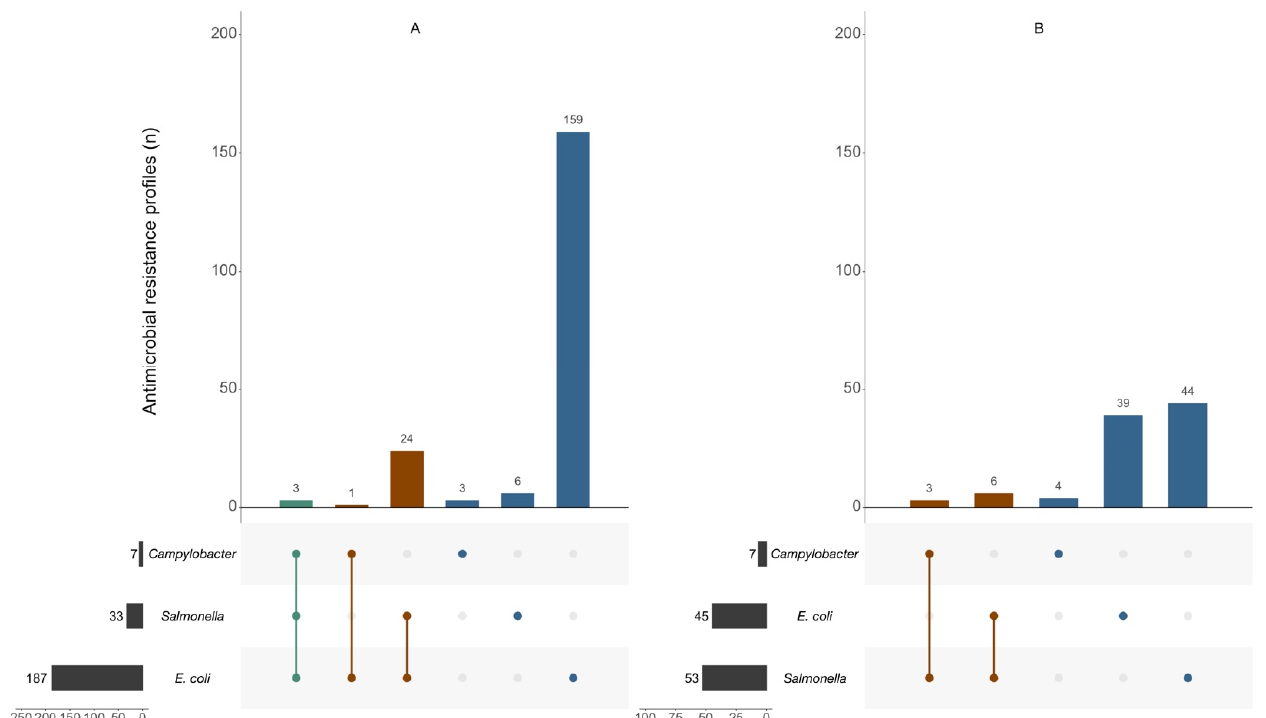
Figure 2. AMR profiles within food-producing animal populations ( A ) and food products ( B ) from Campylobacter , Salmonella, and E. coli isolates, 2014–2019. Dots represent the type of bacteria and connecting lines indicate that profiles are common between bacteria. Colours represent shared profiles between bacteria, green—all types of bacteria; red—two types of bacteria, and blue—one type of bacteria, representing unique profiles. The number of distinct AMR profiles identified for each bacteria are presented in horizontal bar graphs displayed on the left.